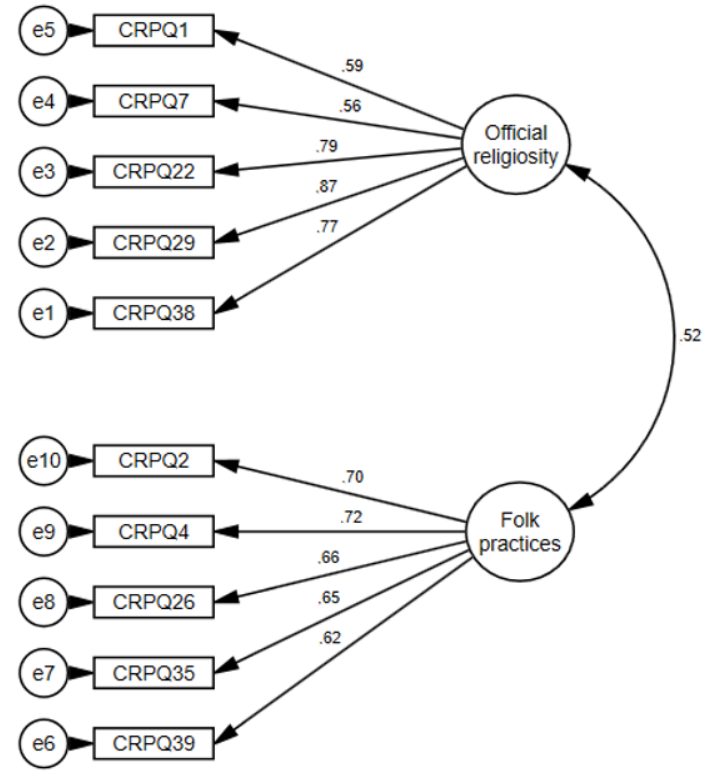
Figure 2. Measurement model of CRPQ.